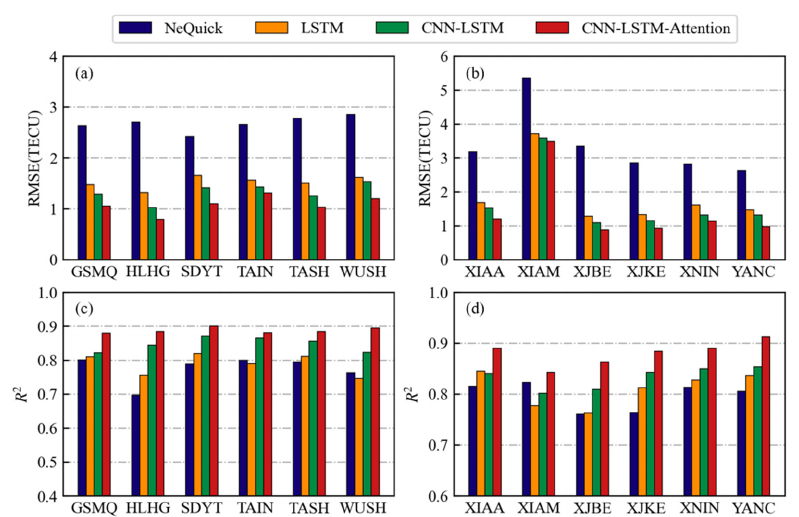
Figure A1. Histogram for RMSE and R 2 of NeQuick (blue), LSTM (yellow), CNN-LSTM (green), and CNN-LSTM-Attention (red) models from other 12 GNSS stations. ( a , b ) are RMSE. ( c , d ) are R 2 .